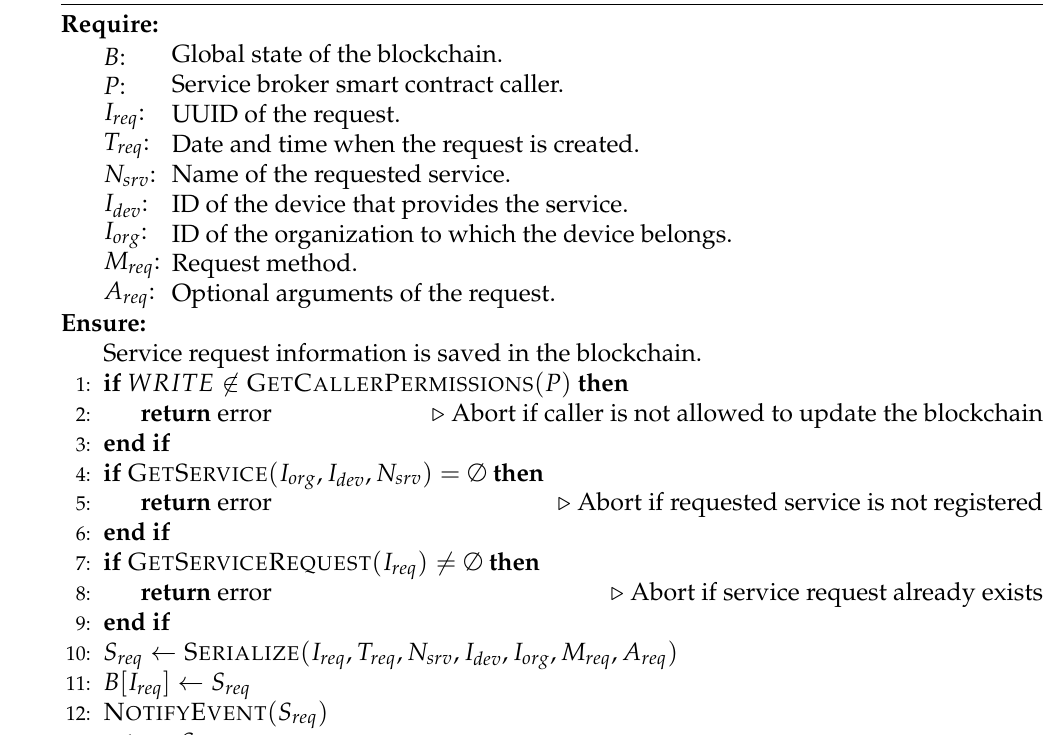
Algorithm 3 Creating a service request using the service